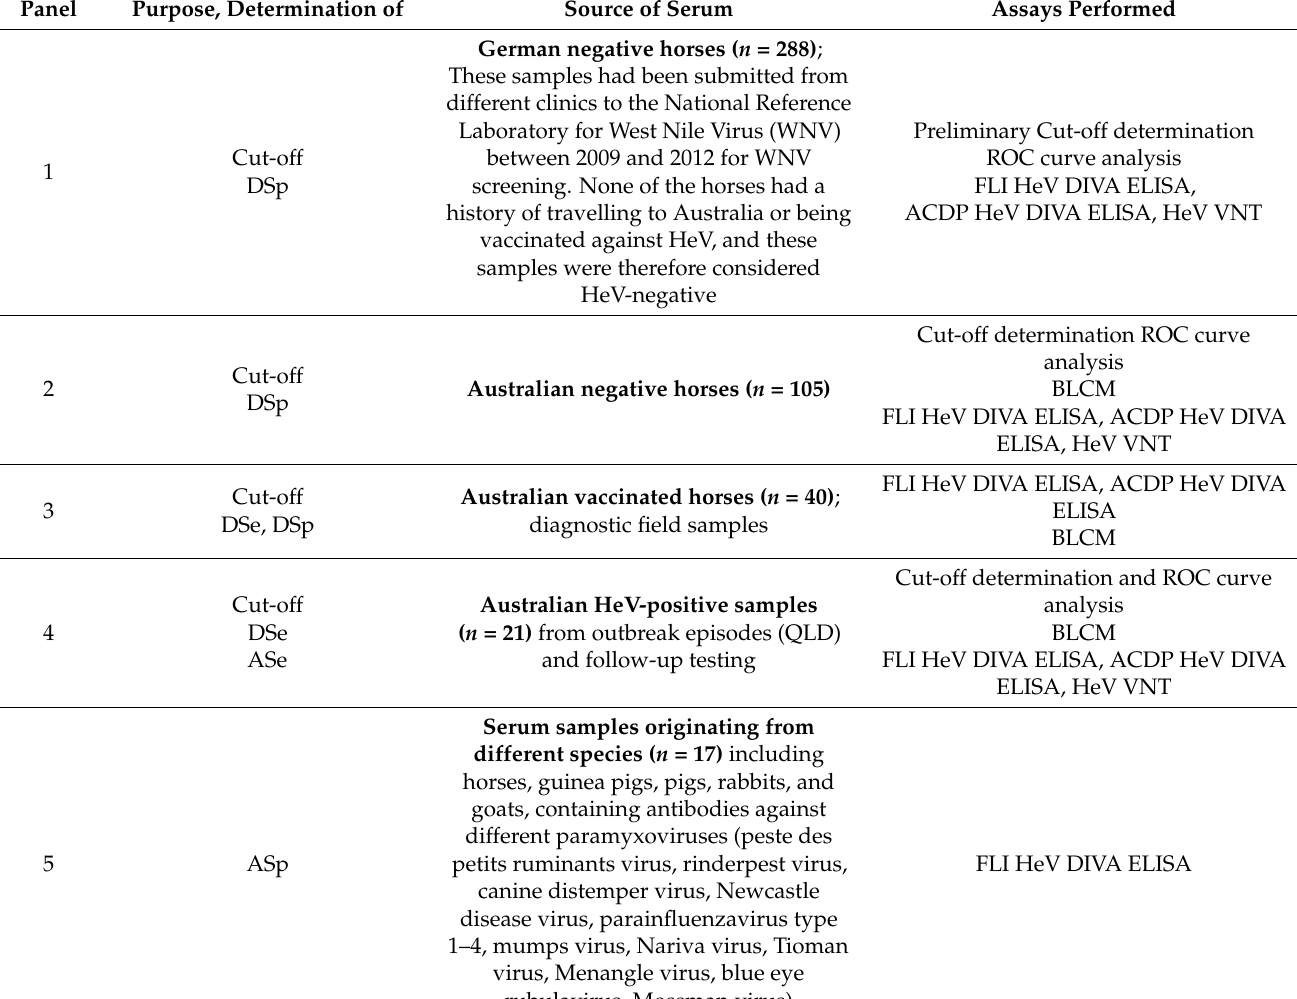
Table 1. Serum panels used for development and evaluation of the FLI HeV DIVA ELISA using HeV-G and HeV-N